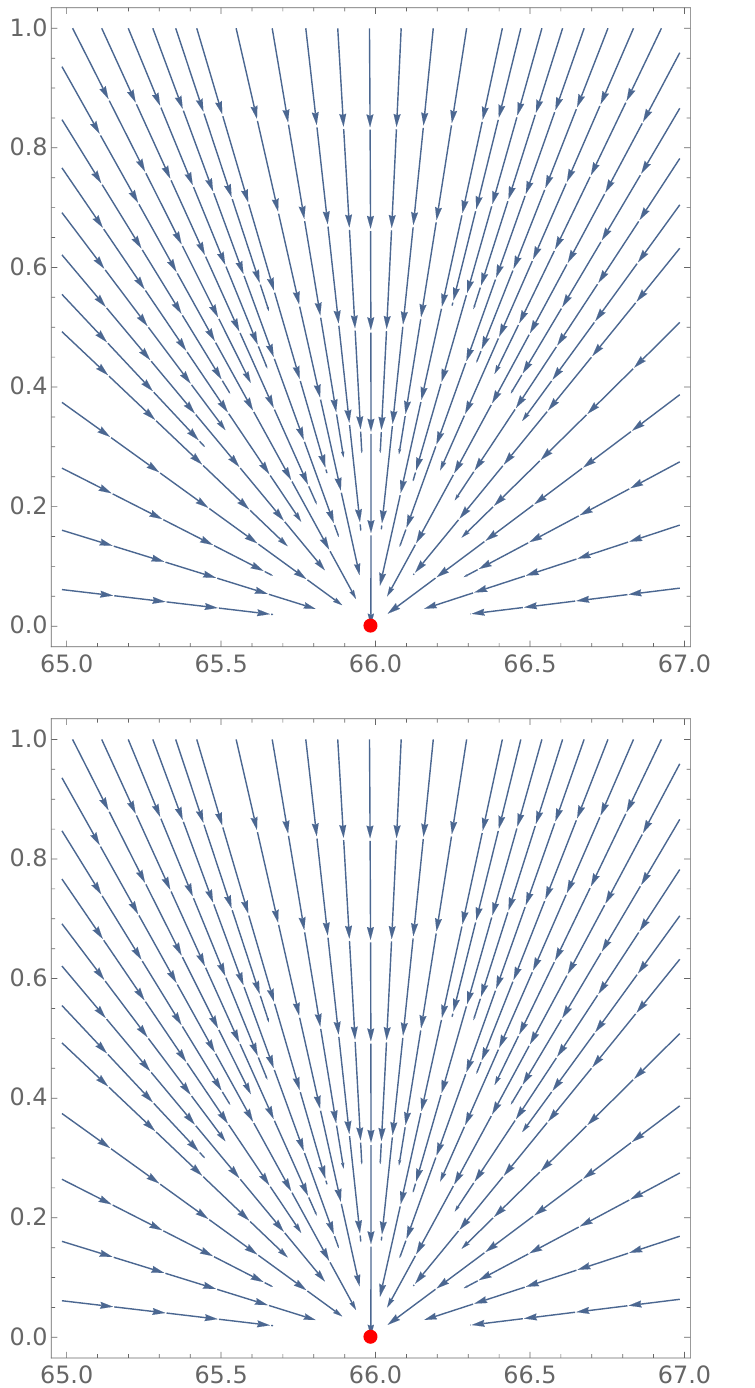
Figure 6 . The (cid:13)ows for ’ = ’ ( (cid:26) ) for the charges Q = (4 ; (cid:0) 9 ; 7 ; 4) T (above) and Q = (4 ; (cid:0) 30 ; (cid:0) 30 ; (cid:0) 5) T (below) leading to attractor point at ’ = 33 + 8